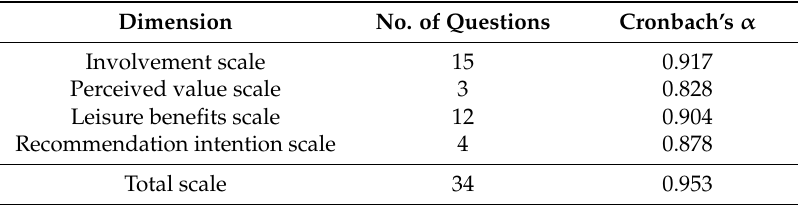
Table 3. Reliability and validity analysis of questionnaire.